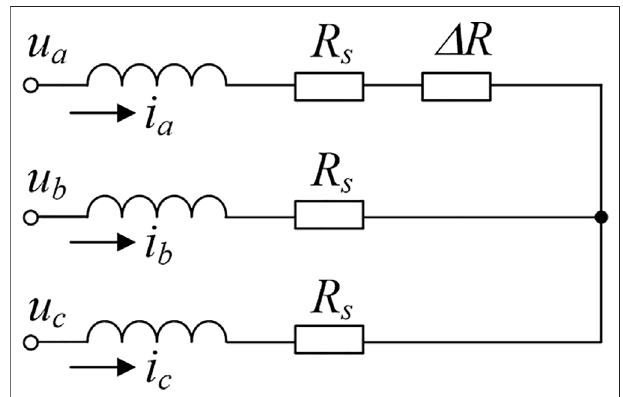
FIGURE 2 | Equivalent circuit model of the PM machine with HRC in phase